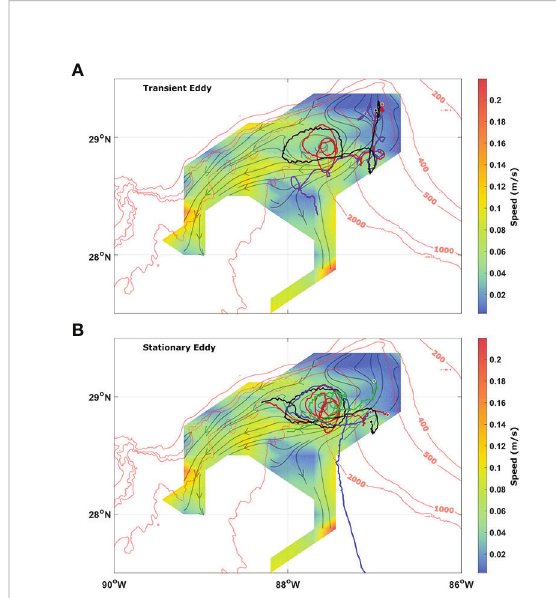
FIGURE 2 Tracks of RAFOS drifters captured by the (A) transient cyclonic eddy and (B) stationary anticyclonic eddy. A circle indicates the start of each track. Mean speed, calculated using all 20 RAFOS tracks over their fi rst 100 days, is colored, with streamlines given in light green. Isobaths are shown in red. RAFOS drifters captured by the transient eddy are 1189 (red), 1194 (purple) and 1195 (black), and the stationary eddy are 1177 (green), 1189 (red), 1195 (black), and 1196 (blue).